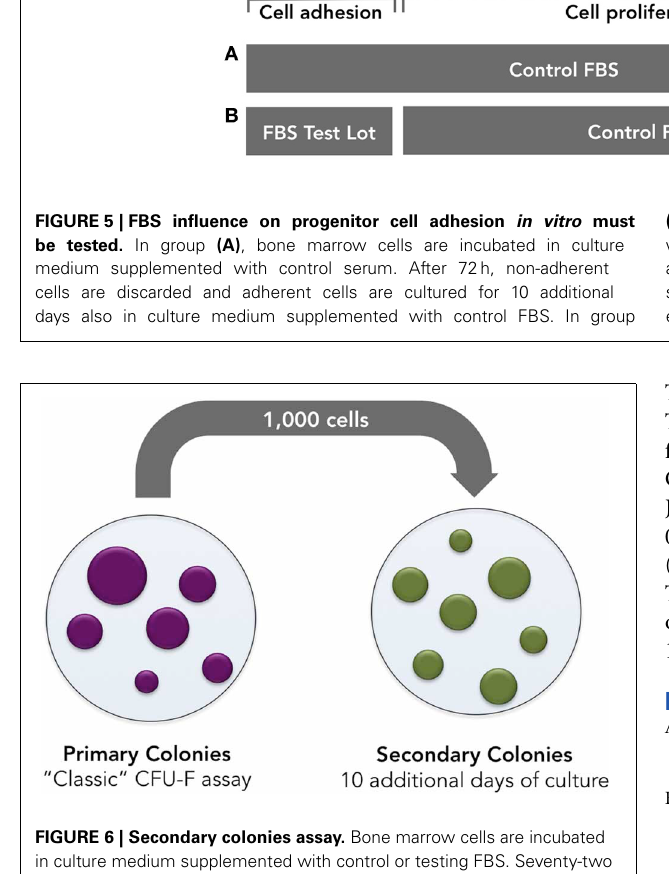
FIGURE 6 | Secondary colonies assay. Bone marrow cells are incubated in culture medium supplemented with control or testing FBS. Seventy-two hours later, non-adherent cells are discarded and adherent cells are cultured in culture medium supplemented with control or testing serum for 10 additional days. Later, cells are tripsinized and single-cell suspension prepared. One thousand cells are subsequently replated and incubated for 10 additional days in culture medium supplemented with testing or control serum. Numbers and size of secondary colonies must be